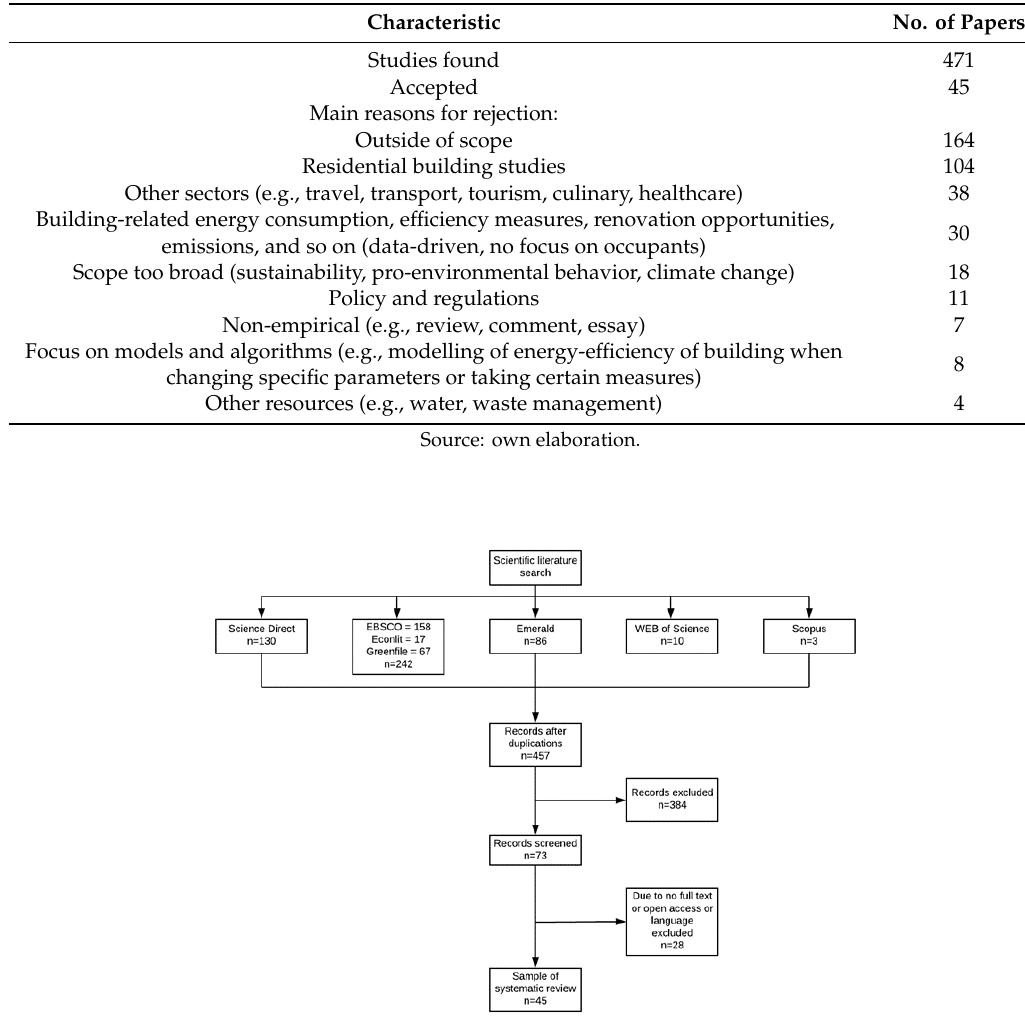
Table 3. Target groups assessed in public buildings.